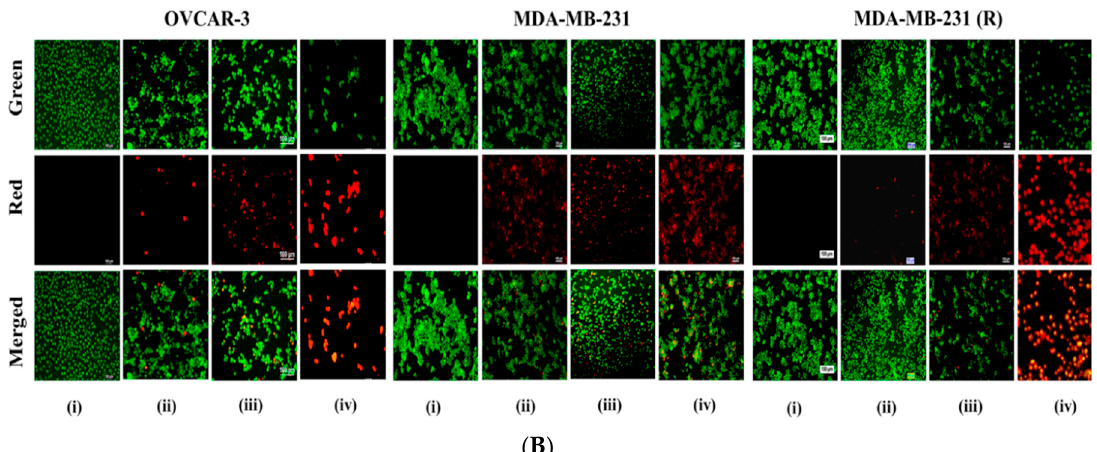
Figure 4. ( A ) In vitro cytotoxic effects of Dox, Dox/F127&P123, and Dox/F127&P123-T f on OVCAR-3, MDA-MB-231, and MDA-MB-231(R) cells; data shown represent mean ± SD in three different experiments ( n = 6) (* p < 0.05, ** p < 0.01, *** p < 0.001); ( B ) live/dead assay of OVCAR-3, MDA-MB-231, and MDA-MB-231(R) cells incubated with (ii) Dox, (iii) Dox/F127&P123, and (iv) Dox/F127&P123-T f for 24 h, visualized with fluorescence microscopy; green and red fluorescence is defined as live and dead cells, (i) untreated group was used as control respectively; scale bars represent 100 μ m.